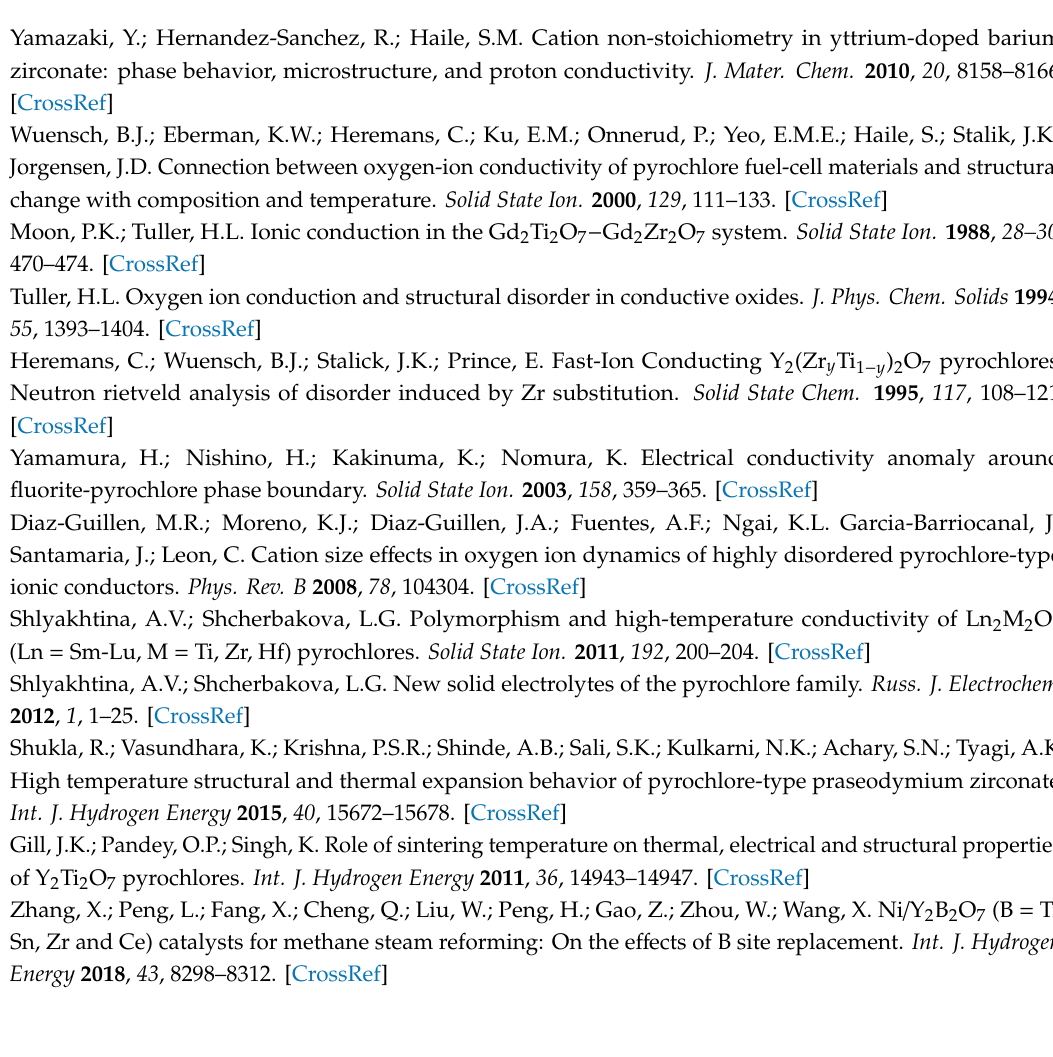
Table S1. Comparison of Rietveld refinement factors for Sm 1.95 Ca 0.05 Zr 2 O 6.975 composition, Table S2. Comparison of Rietveld refinement factors for Sm 1.9 Ca 0.1 Zr 2 O 6.95 composition, Figure S1. Mapping of the area with the micron-size agglomerate formed from small grains (Figure 3c): (a) Ca; (b) Zr; (c) Sm; (d) overlapping of the maps for individual